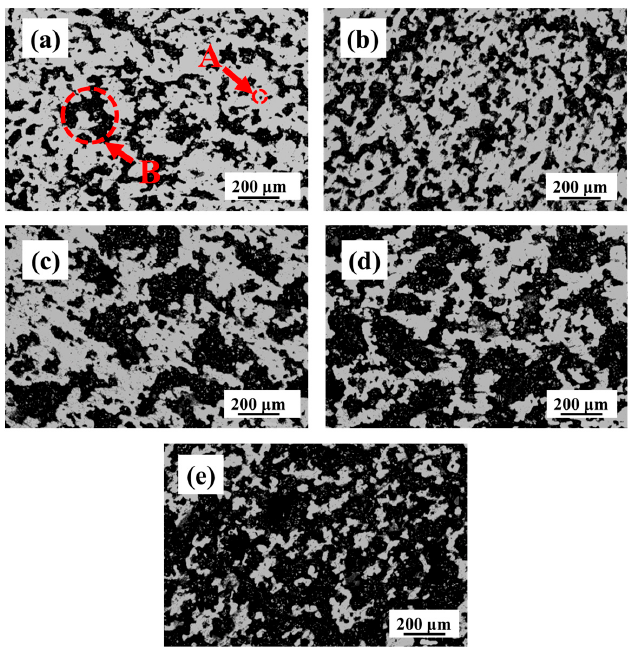
Figure 1. Micrographs from Ti-10Mo alloys with different contents NH 4 HCO 3 added: ( a ) 63%; ( b ) 67%; ( c ) 71%; ( d ) 75%; ( e ) 79%.